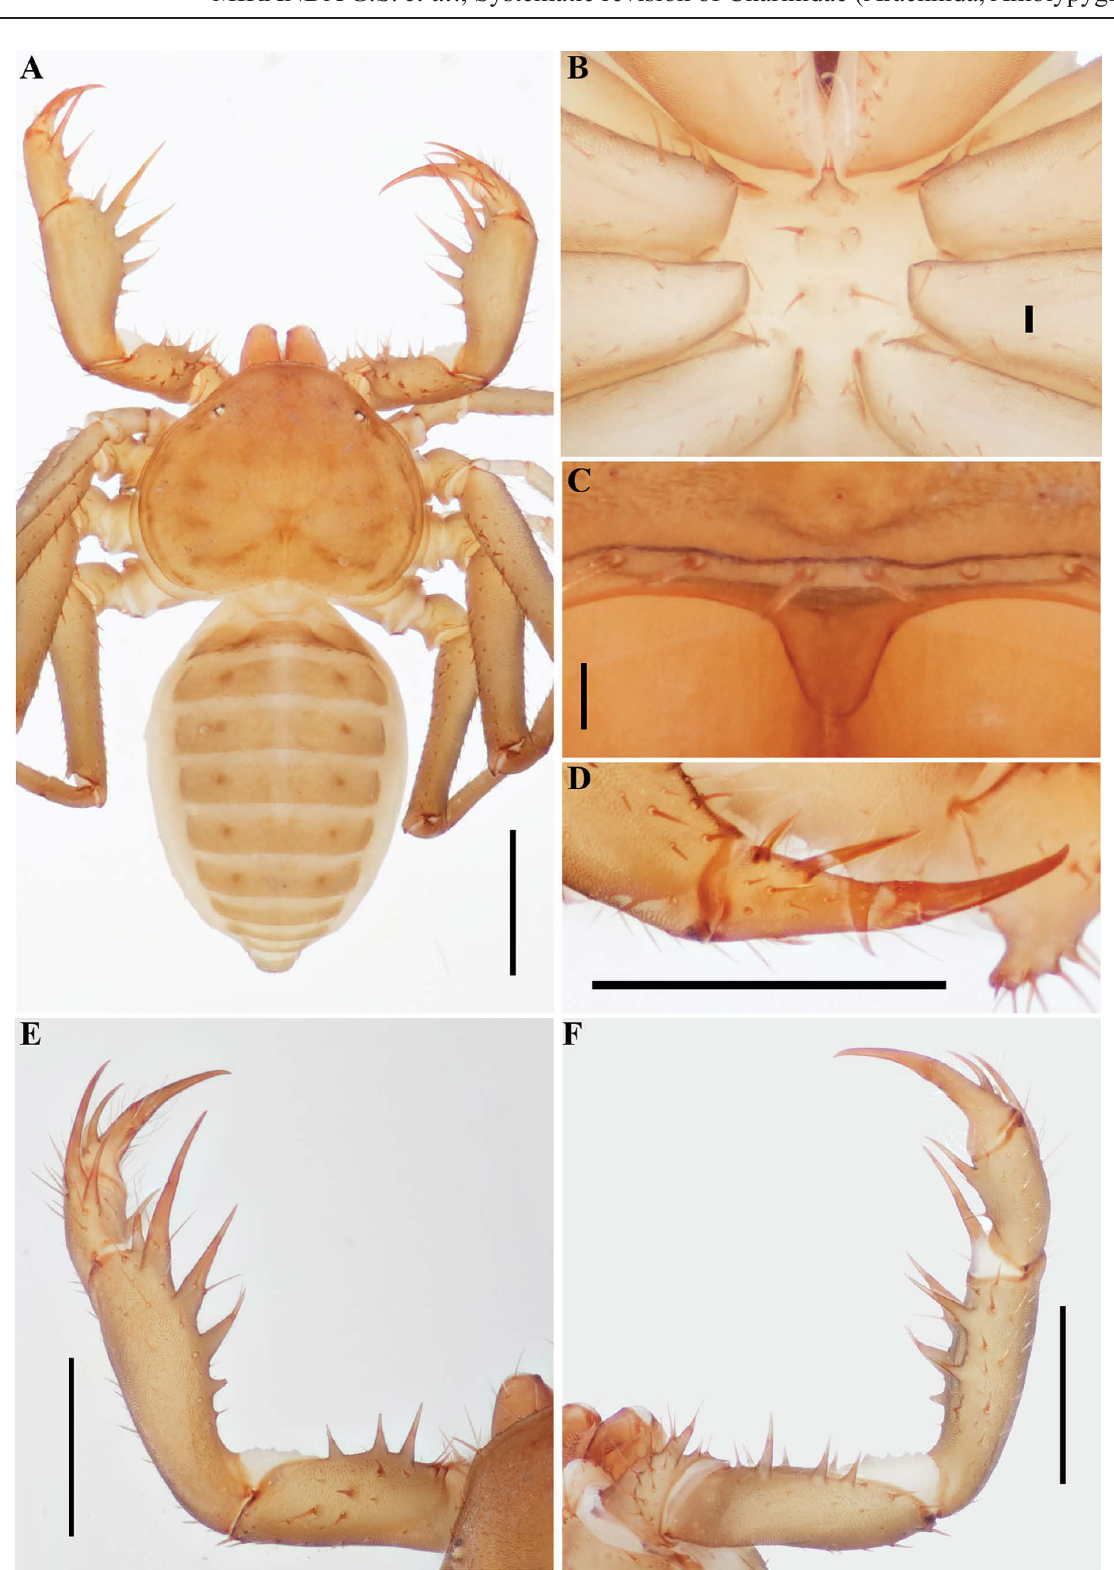
Fig. 21. Charinus dominicanus Armas & Perez, 2001 (AMCC [LP 10473]), general morphology, ♂. A . Habitus, dorsal view. B . Sternum, ventral view. C . Frontal process. D . Pedipalp tarsus, frontal view. E . Pedipalp, dorsal view. F . Pedipalp, ventral view. Scale bars: A, D–F = 1 mm; B–C =